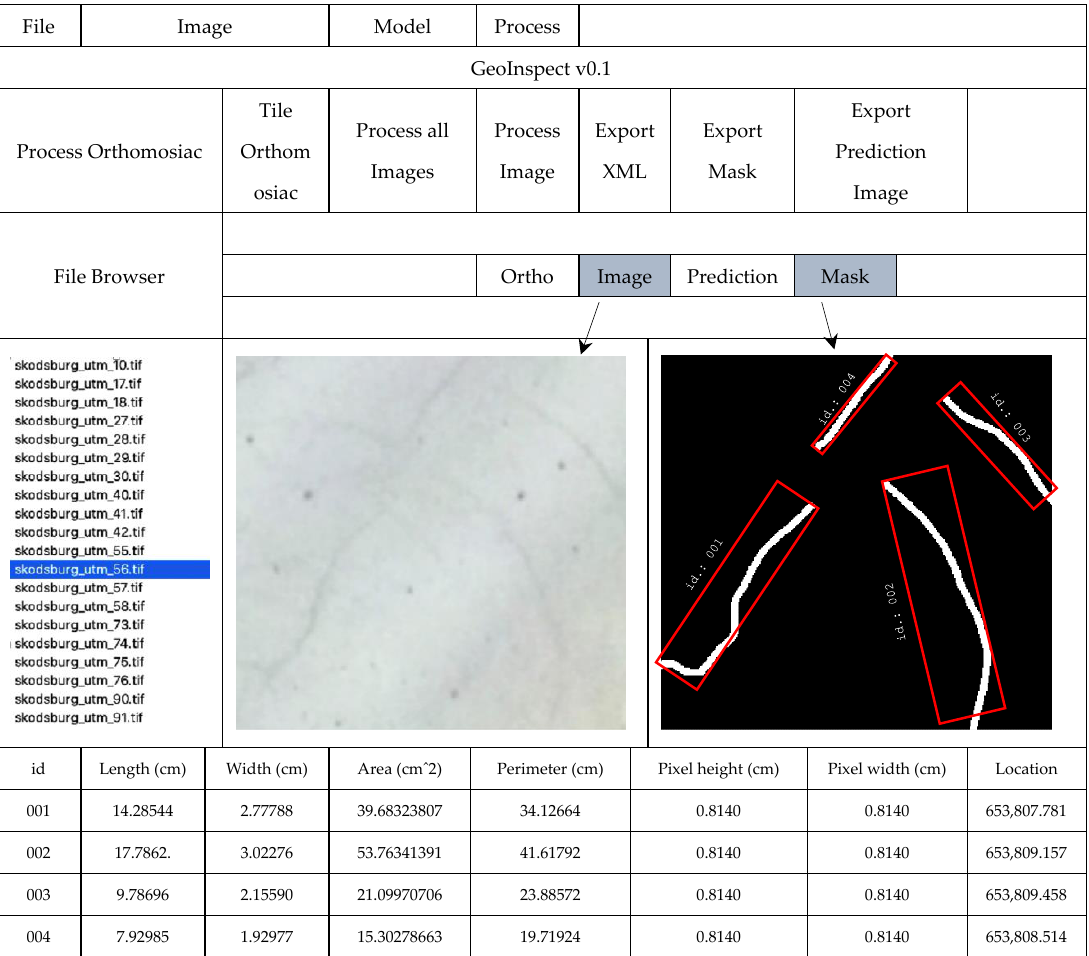
Figure 10. Graphical User Interface (GUI) outline of the crack segmentation Mask RCNN analysis for one of the drone images of Skodsberg